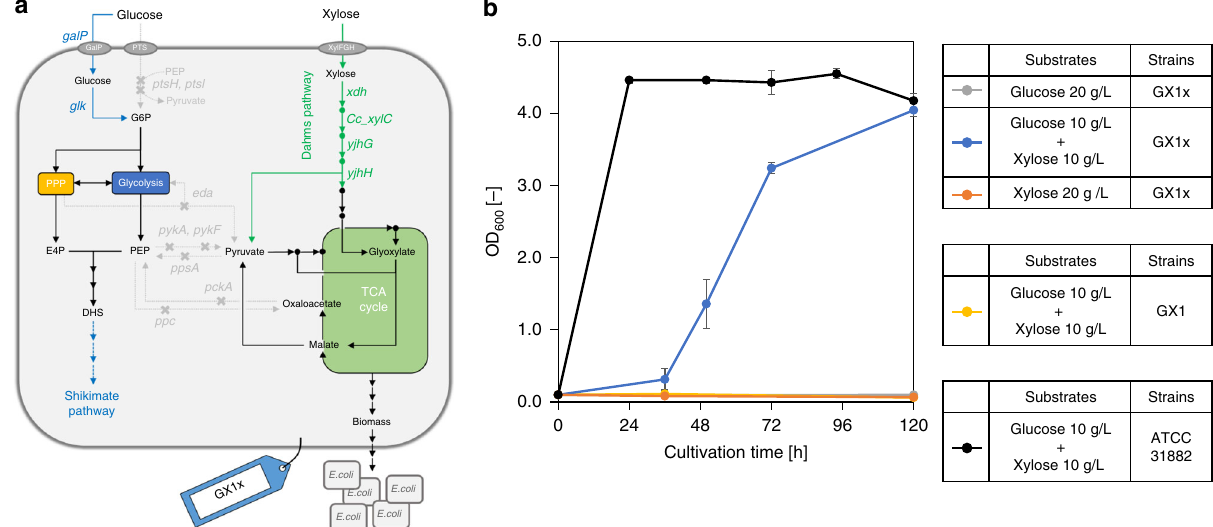
Fig. 4 Examination of the growth of the strain in which the Dahms pathway was introduced. a Metabolic design of the GX1x strain. b Bacterial cell growth in minimal medium. Gray, blue, and orange symbols indicate the growth of the GX1x strain cultured in medium containing only glucose, a glucose – xylose mixture, and xylose alone, respectively. Yellow symbols indicate the growth of the GX1 strain (i.e., a strain lacking the Dahms pathway) cultured in medium containing a glucose – xylose mixture. Black symbols indicate the growth of the ATCC31882 (control strain) cultured in medium containing a glucose – xylose mixture. G6P glucose-6-phosphate; PEP phosphoenolpyruvate; E4P erythrose 4-phosphate; and DHS dehydroshikimate. The data are presented as the average of three independent experiments, and error bars indicate standard errors. Source data underlying Fig. 4b are provided as a Source Data fi